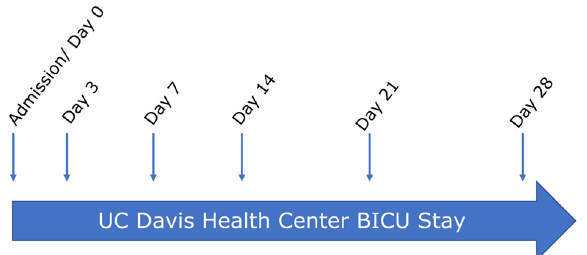
Figure 1. Longitudinal Sampling Schedule. This figure was generated by the author using the software Inkscape 12